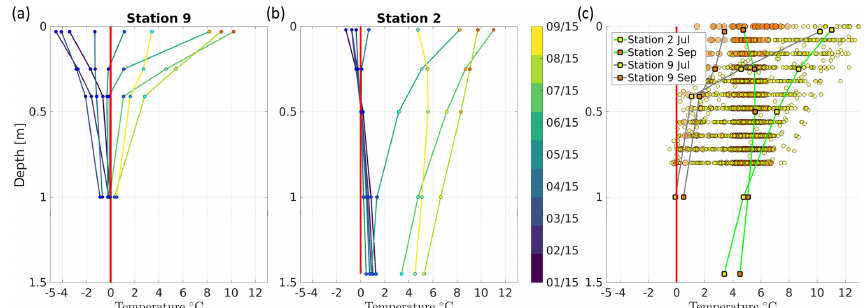
Figure 4. Temperature profile at Station (a) 9 and (b) 2 at the middle of every month (from 15 January 2017 to 15 September 2017). The 0 ◦ C line is in bright red. (c) Comparison of temperature measurements at Station 2 and 9 (solid lines) with DTP measurements (circles) along transects A to E on 17 July (yellow) and along transects B and C on 20 September (orange).